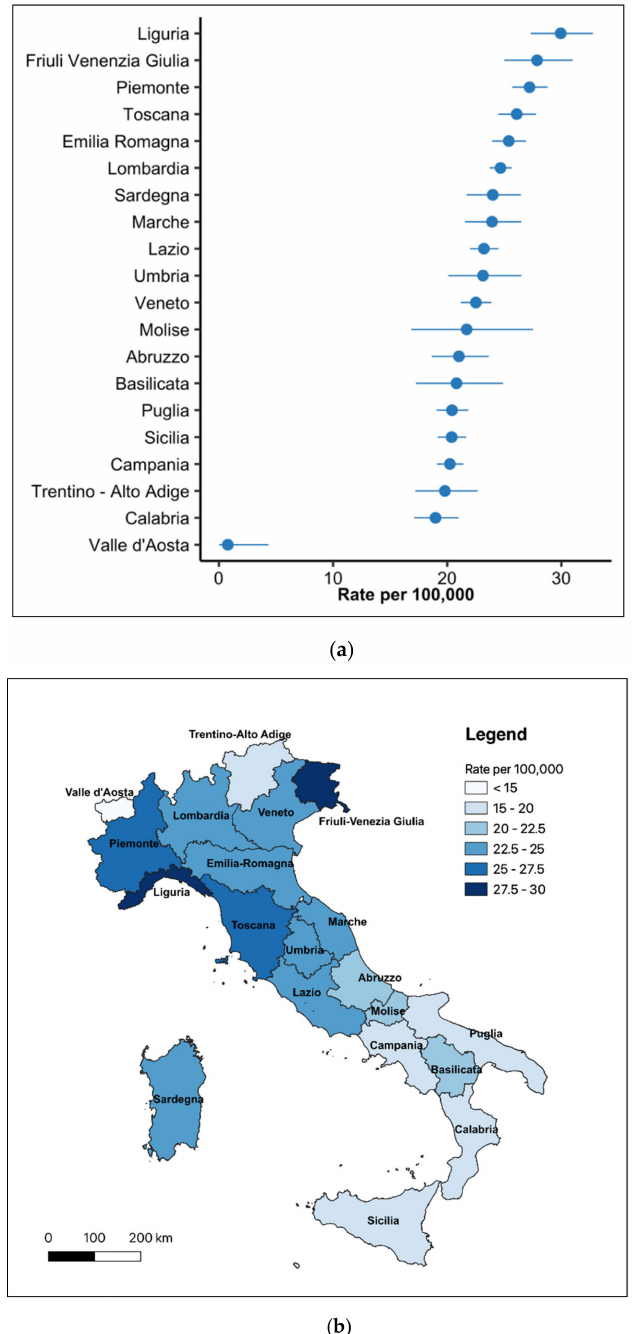
Figure 2. Regional estimates of cancer deaths due to carcinogenic infections per 100,000 inhabitants, Italy, 2015. ( a ) Death rates (dots) and 95% confidence intervals (lines); ( b ) Geographical distribution of death